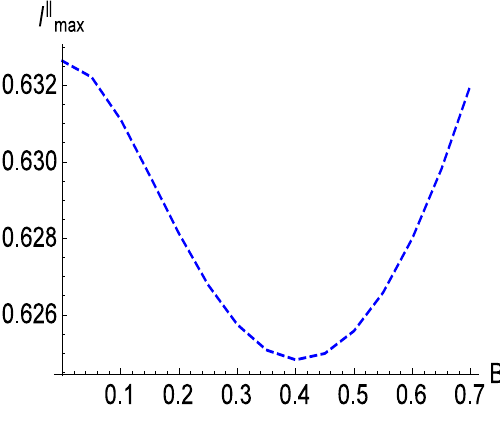
Figure 4 . ‘ k max as a function of B for c = 1. In units